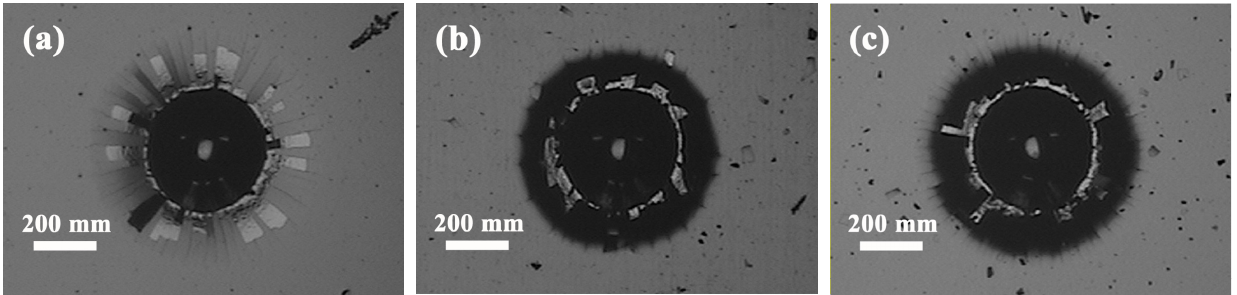
Figure 3. The OM images of Rockwell C indentation of (Al 0.34 Cr 0.22 Nb 0.11 Si 0.11 Ti 0.22 ) 50 N 50 coatings on WC/Co substrates with various interlayer: ( a ) Cr interlayer, ( b ) Al 0.34 Cr 0.22 Nb 0.11 Si 0.11 Ti 0.22 interlayer, and ( c ) Ti